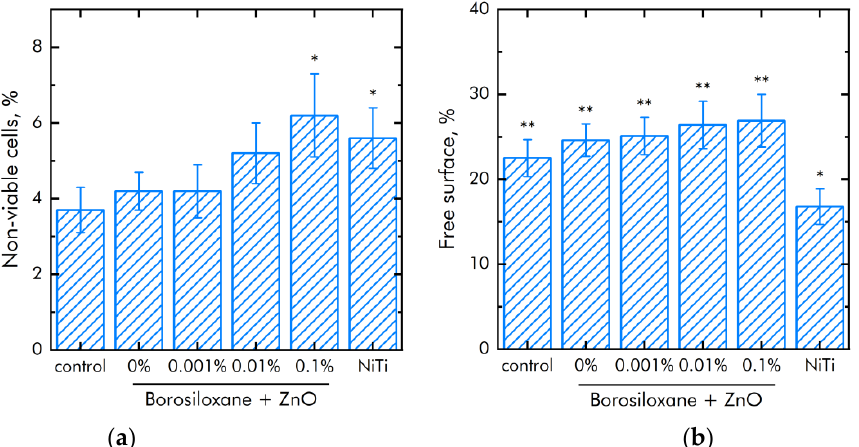
Figure 9. Effect of composite material based on borosiloxane and zinc oxide nanoparticles on the main characteristics of mouse primary dermal fibroblasts cell culture growth and development: ( a ) Cell viability; ( b ) Colonization rate; * indicate a significant difference at 5% level in comparison with the control ( p < 0.05). ** indicate a significant difference at 5% level in comparison with the NiTi group ( p < 0.05). Data are presented as mean values and standard errors.